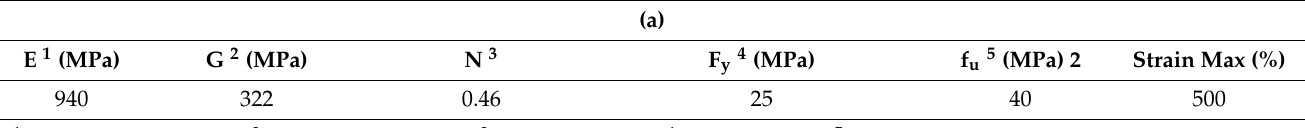
Figure 1. ( a ) Common parts of a Total Hip Arthroplasty (lateral cross-section). ( b ) Summary of parameters and variables analyzed with Cervical-Diaphyseal Angle in Normal, Varus and, Valgus. Table 1. ( a ) Mechanical properties of UHMWPE liner. ( b ) Mechanical properties of femoral head and equations of contact Hertz theory. ( c ) Biomechanics and geometrical values.